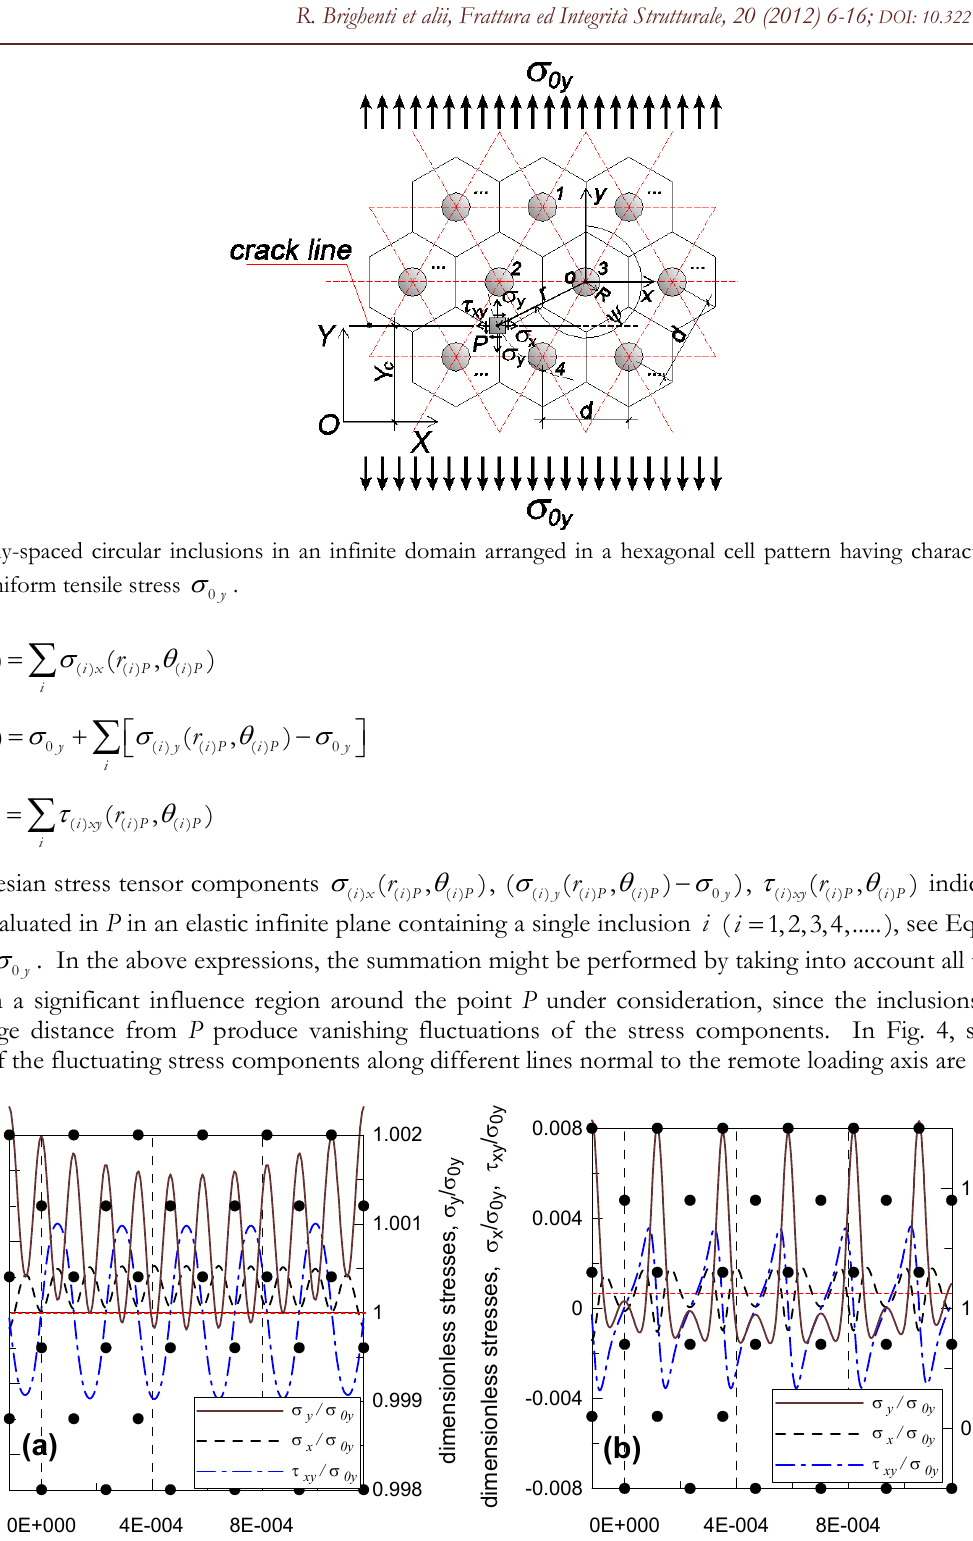
 . Dots indicate the positions of inclusions in 0 y